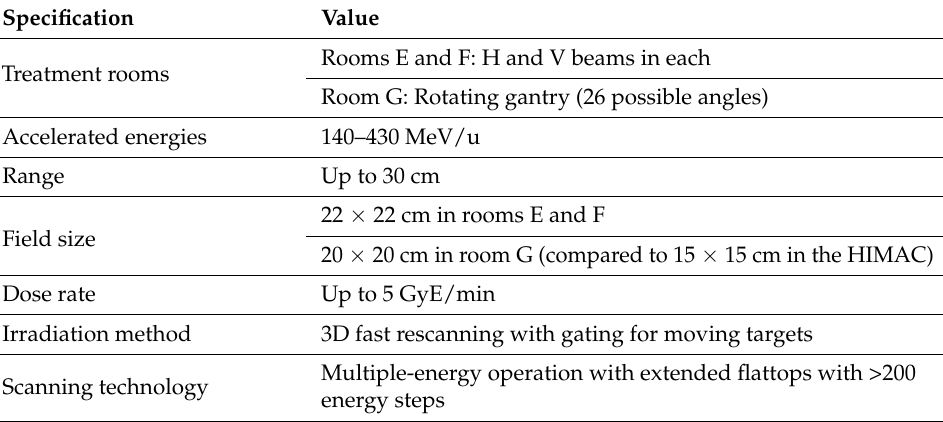
Table 1. Major specifications of the new particle therapy research